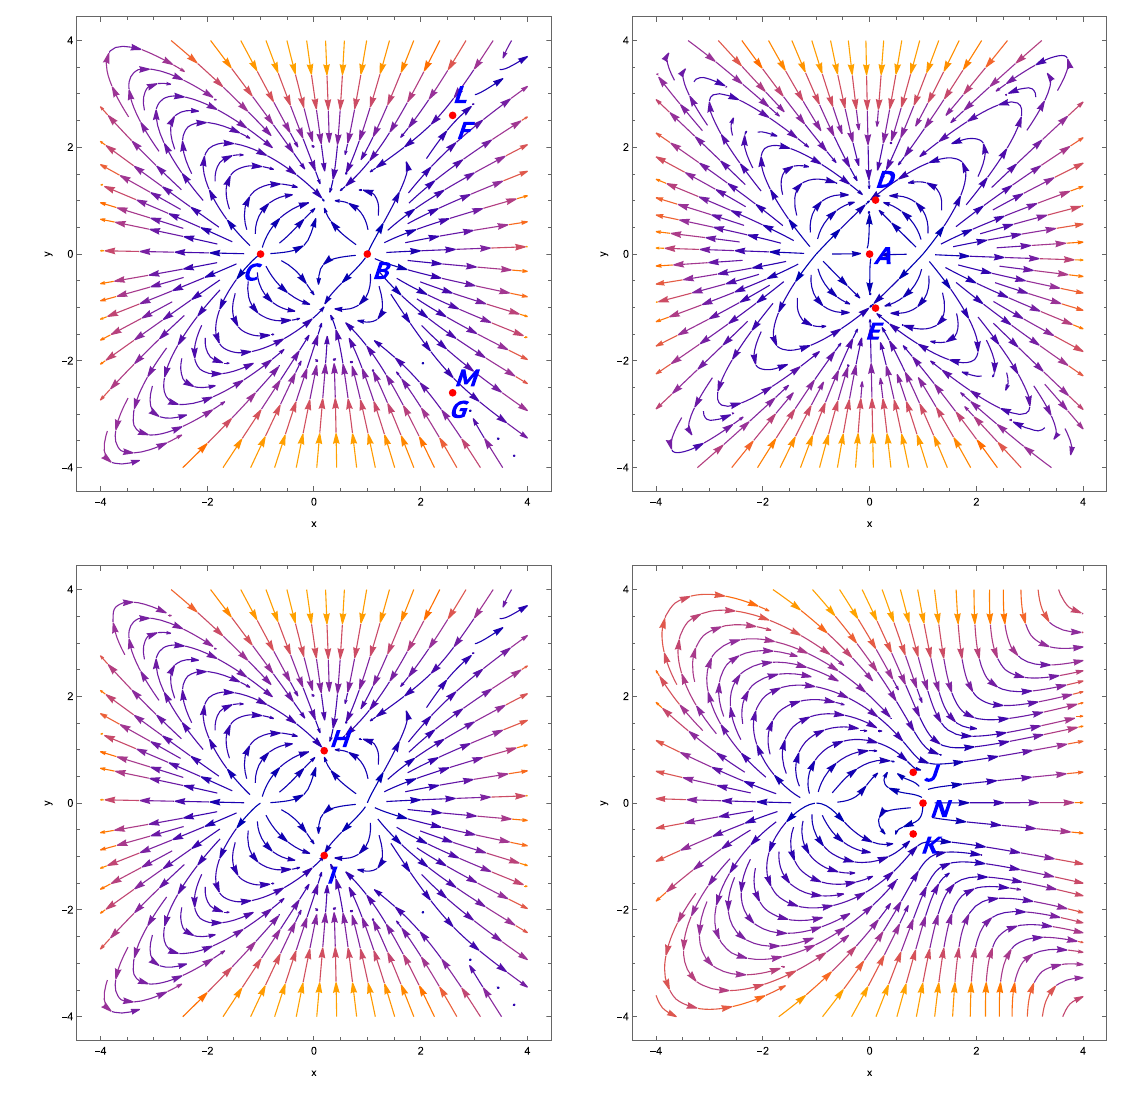
Fig. 1 Phase portrait for above dynamical system, the upper left plot is for u = 0, ρ = 0, λ = u = 0, ρ = 0, ζ = 1 , τ = 1, α = 1 . 1, lower left phase portrait is for u = 0, ρ = 0, λ = 9